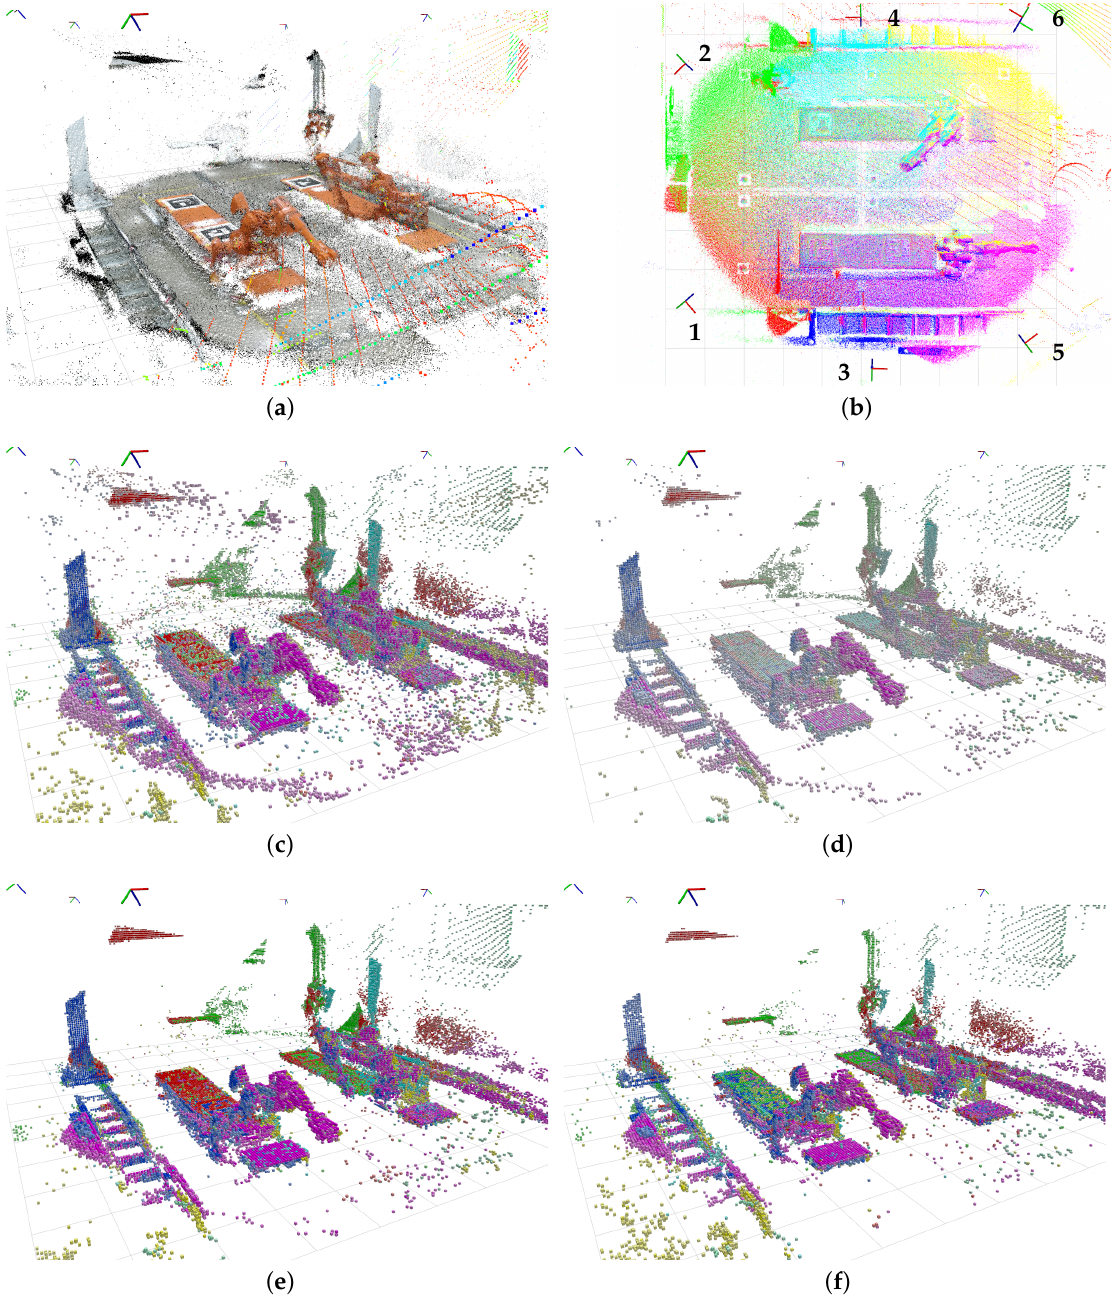
Figure 11. ( a ) original point clouds from all sensors, including color information for the Kinect sensors; ( b ) top down view of original point clouds, where the different sensors’ points are color coded; ( c ) reconstructed, unfiltered point cloud; ( d ) cloud with “point count” voxel intensities, filter value 2; ( e ) cloud with “linear” intensities, filter value 64; ( f ) cloud with “quadratic” intensities, filter level 64. In all the filtered clouds, almost all points generated by the Velodyne lidar (best seen as the olive-colored points on the right wall) are conserved, due to the fact that the intensity is generated by the sensor itself and not calculated, and that these values are higher than the filter values. This